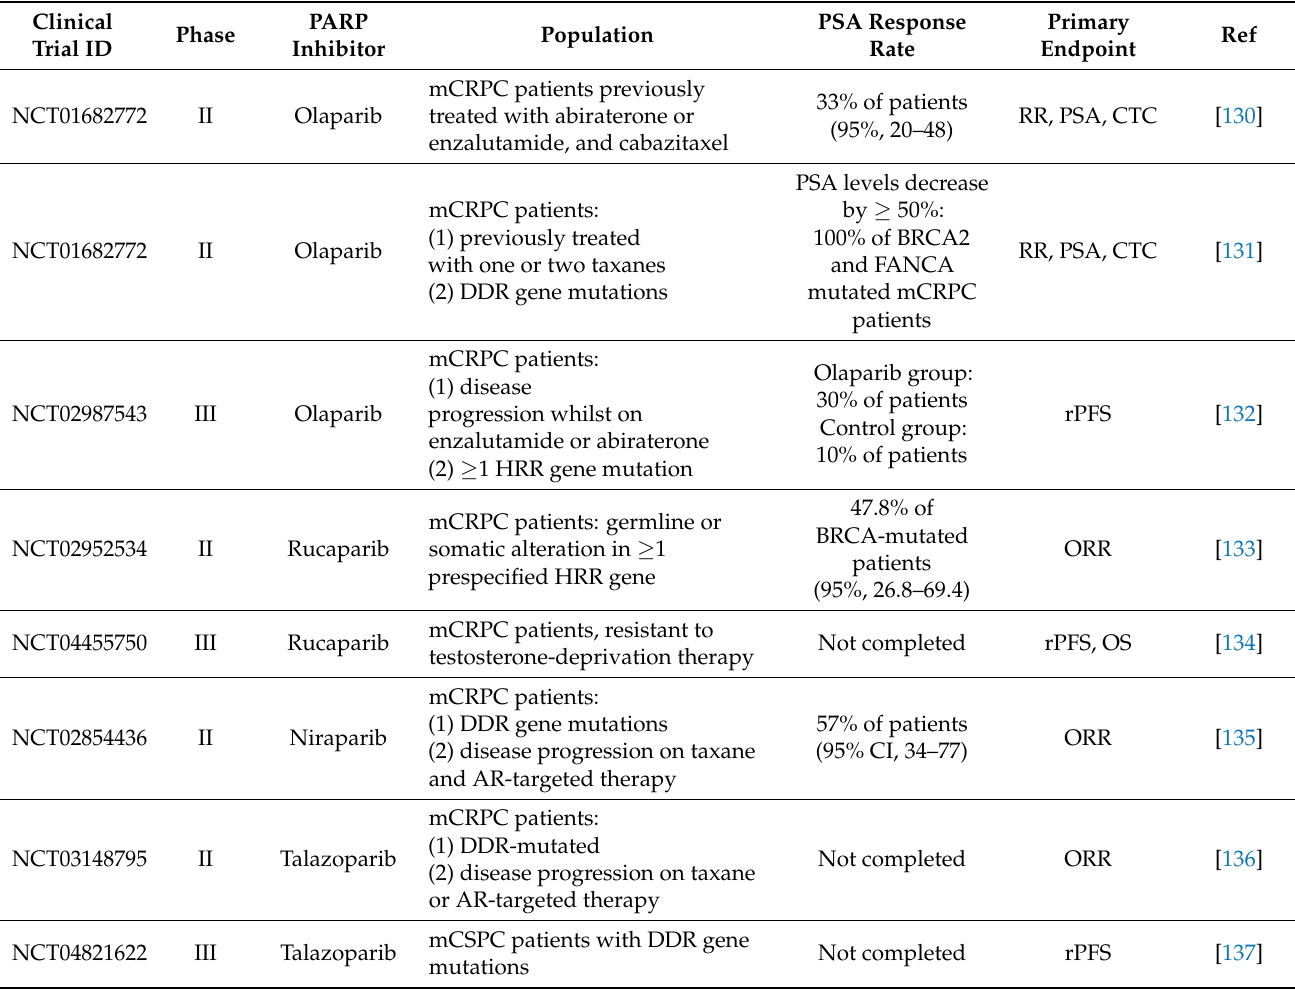
Table 2. Clinical trials of PARP inhibitors in prostate